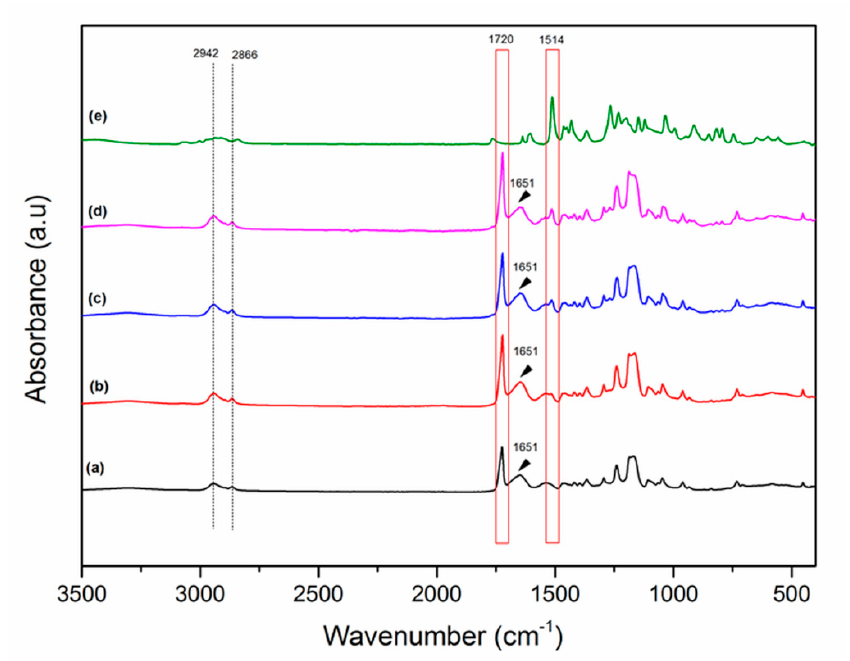
Figure 3. The Fourier-transform infrared spectroscopy (FTIR) spectra of PCL-GEL ( a ), PCL-GEL / CLV1.5 ( b ), PCL-GEL / CLV3 ( c ), and PCL-GEL / CLV6 ( d ) nanofiber mats and pure CLV ( e ).